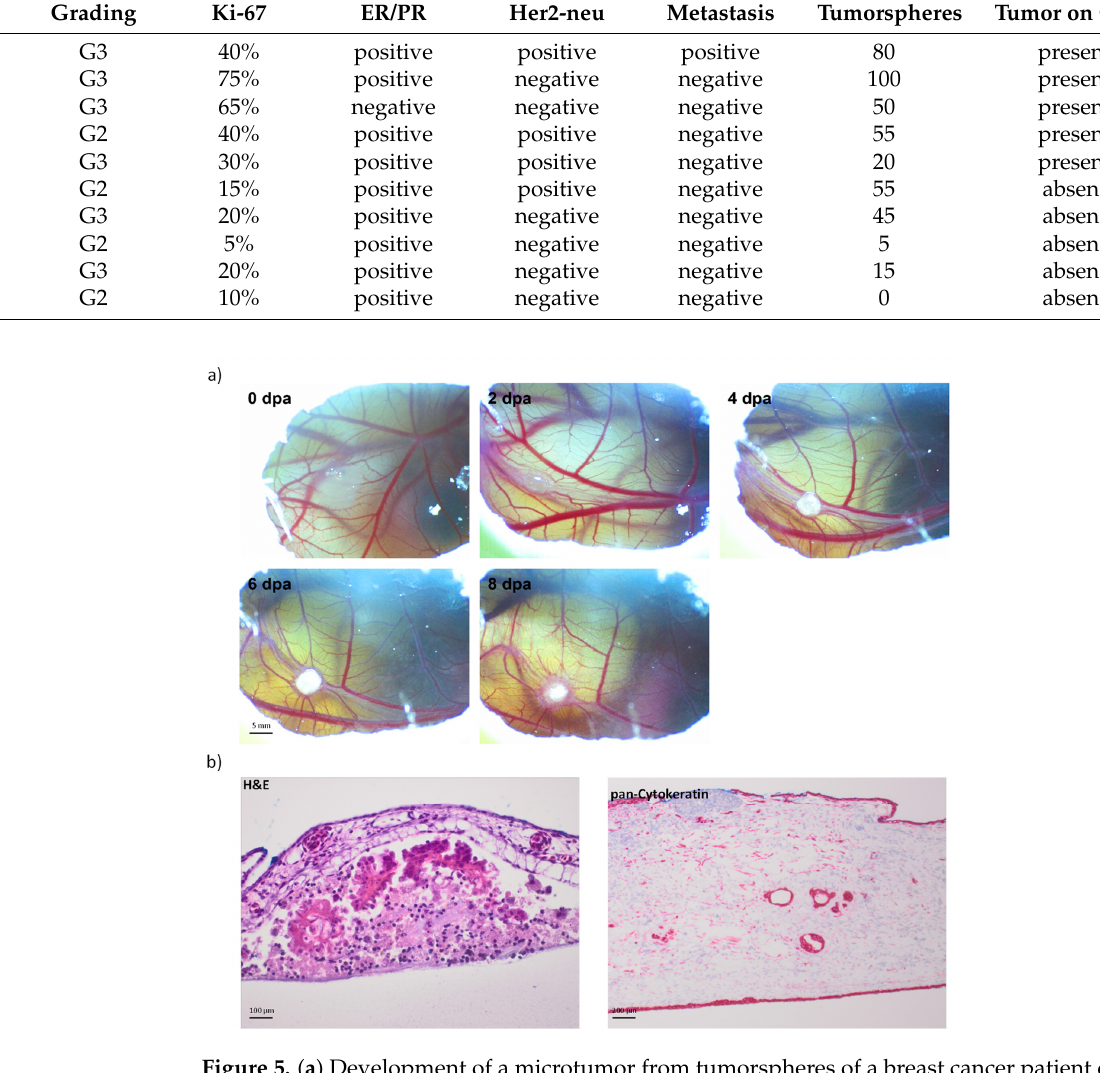
Figure 6. ( a ) Box plot analysis of the number of tumorpheres cultured from peripheral blood in patients who developed a tumor or not on the CAM membrane. ( b ) Box plot showing the Ki-67 proliferation index of primary tumor in patients with breast cancer, with or without tumor on CAM membrane. The horizontal line in box-plot depicts median value. Tumor on CAM